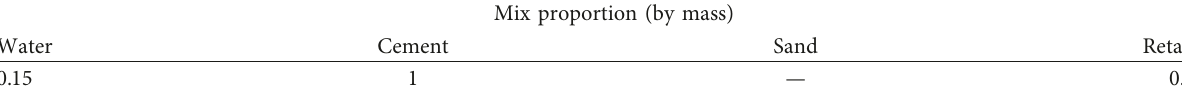
Table 6: Mix proportion of joint filling.